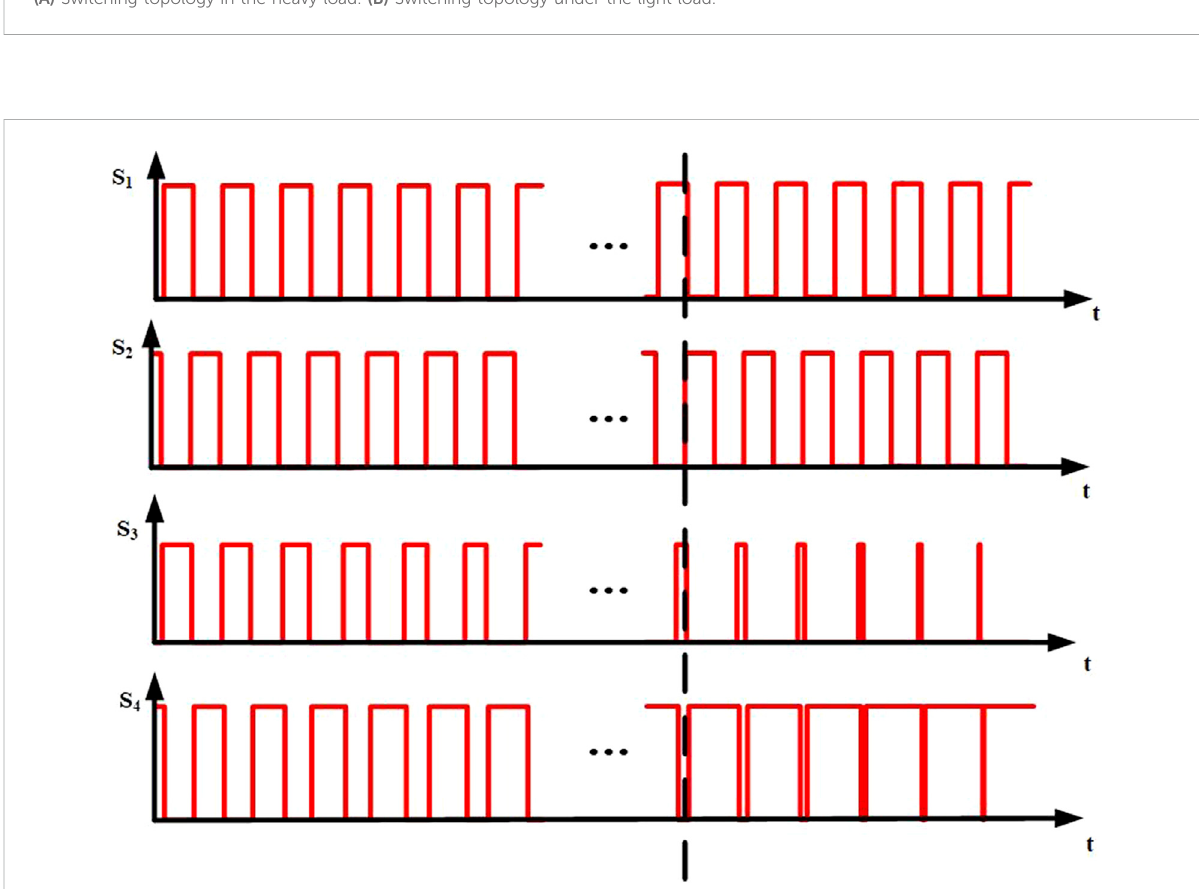
FIGURE 8 Drive signal during